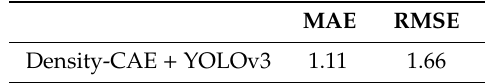
Table 3. Evaluation of the continuous image model for afternoon.